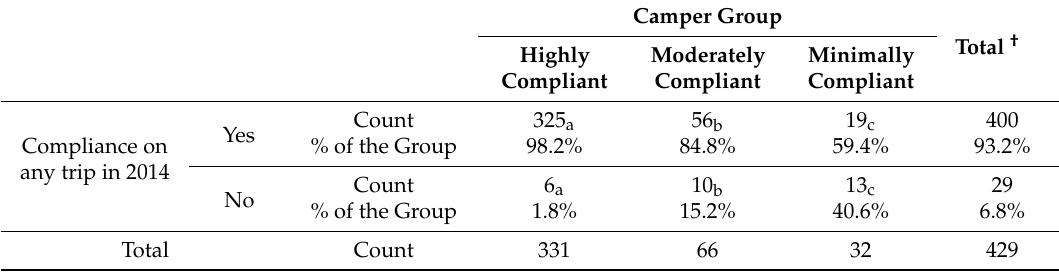
♦ Each table subscript letter denotes a subset of categories whose column values do not differ significantly from each other at the 0.05 level. Bonferroni corrections were applied to account for the fact that multiple comparisons were being made. † The compliance percentage shown in this column differs slightly from that reported in Table 4 due to missing data based on source